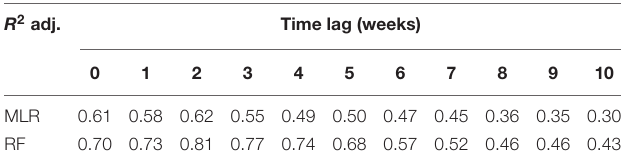
TABLE 3 | Predictive accuracy as measured by R 2 adjusted for different time lags (in weeks), for multiple linear regression (MLR) and random forest (RF) models in upper Ter River basin (NE Catalonia, Spain) in